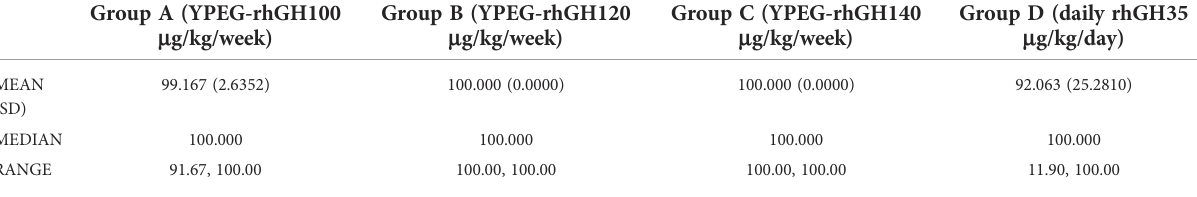
TABLE 5 Treatment adherence over 12 weeks of treatment in FAS.